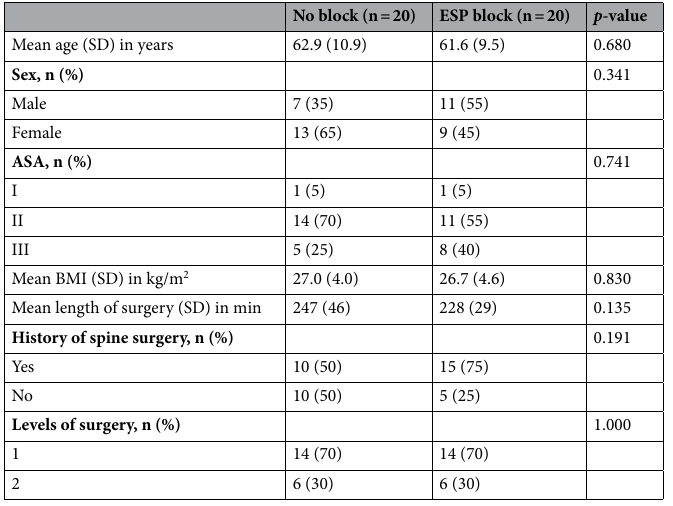
Table 1. Demographics. SD, Standard deviation: ASA, American Society of Anesthesiologists. An independent samples T-test was used to compare means; for categorical variables a Fisher’s exact test was used.